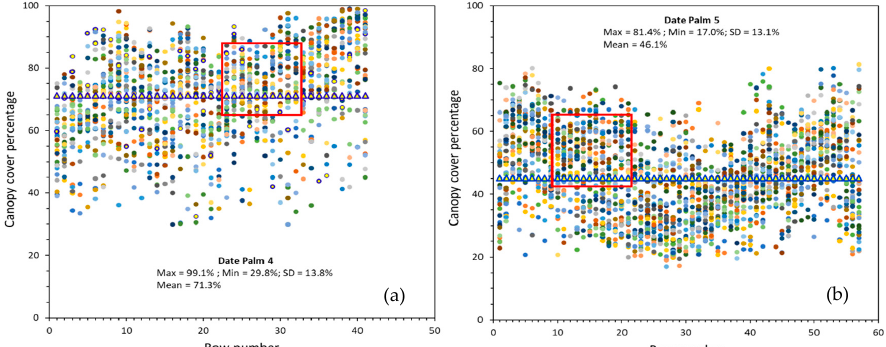
Figure 3. Canopy cover percentage of each living tree at the ( a ) DP4 and ( b ) DP5 sites. There were 41 rows and 41 columns at the DP4 site, and 58 rows and 51 columns at the DP5 site. The red box shows the corresponding canopy cover trees located in a 100 m × 100 m area around the monitoring flux towers. The canopy cover percentage of trees can be read using the row numbers, while dots (trees) with the same colors belong to the same row.